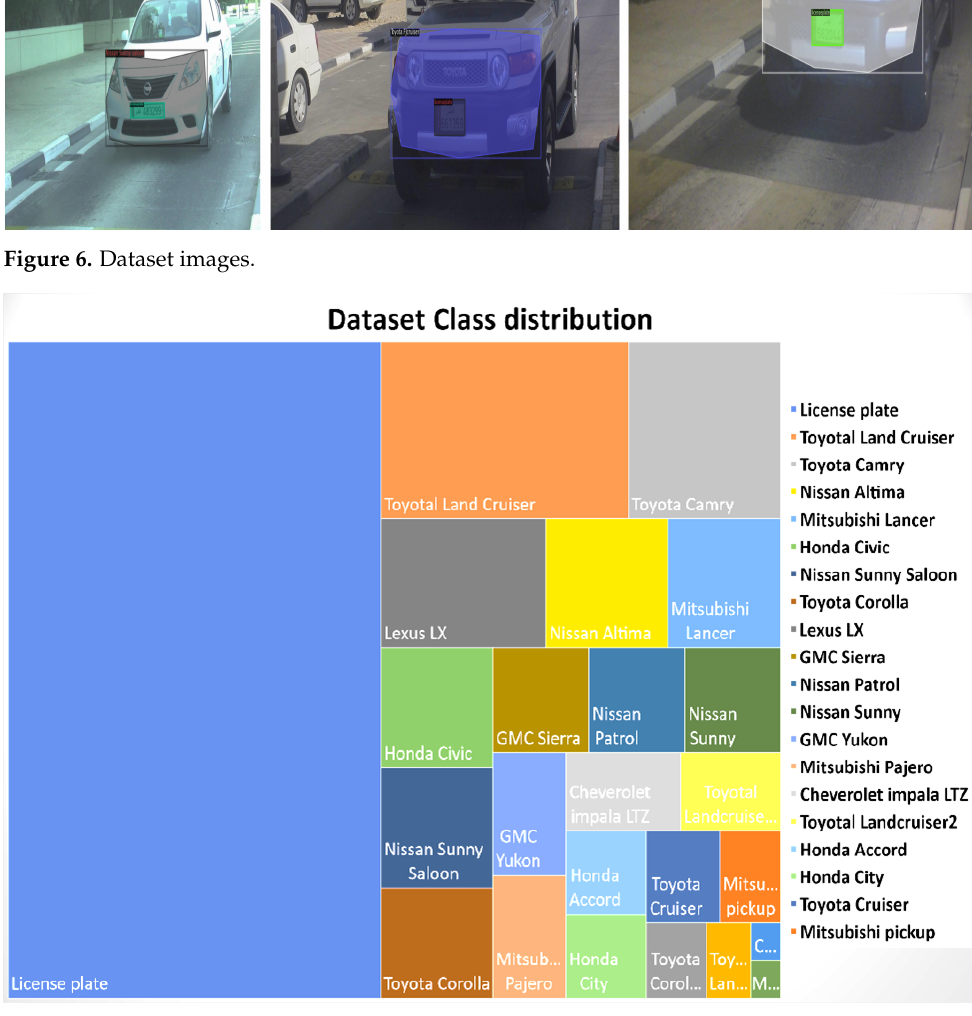
Figure 7. Dataset